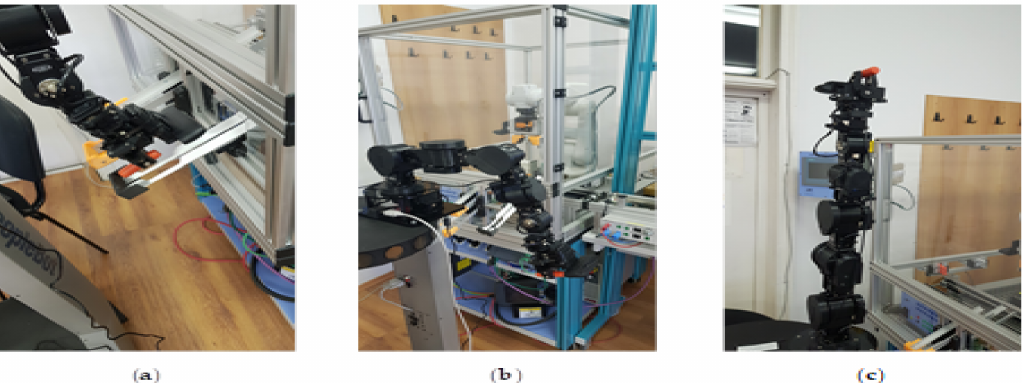
Figure 19. Real-time control of the RM Cyton 7-DOF located at the FC with the following sequences: ( a ) lifting object, ( b ) moving to the intermediate position, ( c ) parking position with the piece in the gripper.